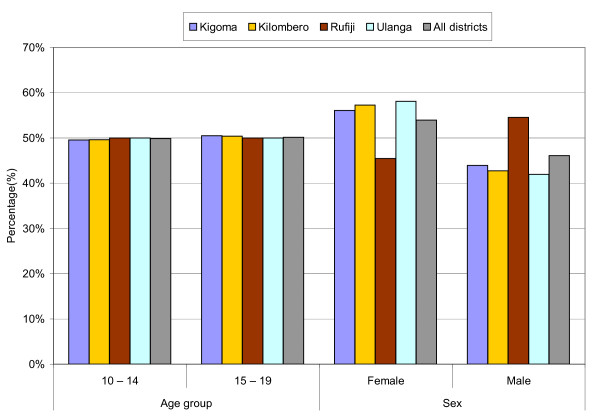
Percentage distribution of adolescent's age group and sex by district of residence in Tanzania, 2008 (N = 612).